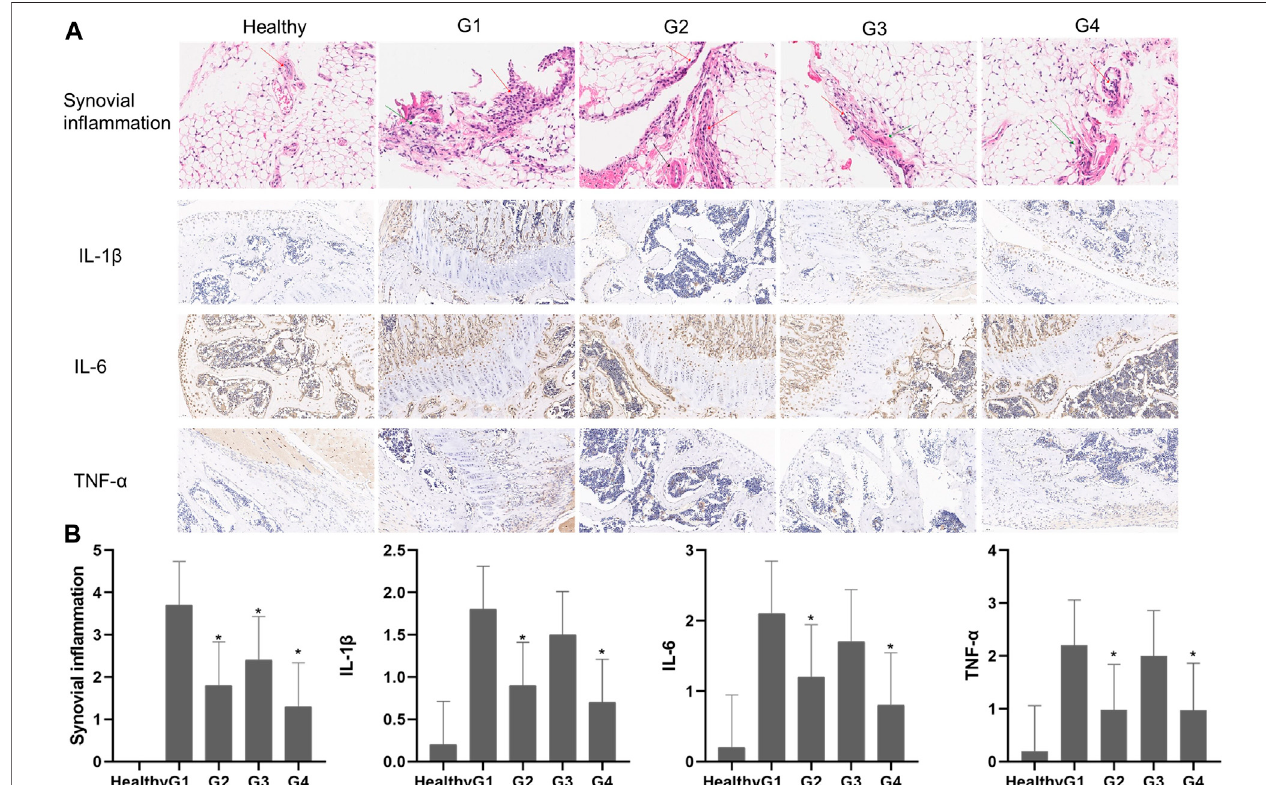
FIGURE 8 | (A) Histological fi ndings of synovial tissues from healthy mice and CIA mice on day 28 after different treatments. H&E (synovial in fl ammation, original magni fi cations × 100, and immunohistochemical staining for IL-1 β , IL-6, and TNF- α , original magni fi cations × 20) (B) Semiquantitative analysis of histopathological evaluation(synovial in fl ammation and immunohistochemicalstainingforIL-1 β ,IL-6,andTNF- α ).Asterisks(*)represent signi fi cance compared withtheuntreated miceat * p < 0.05.